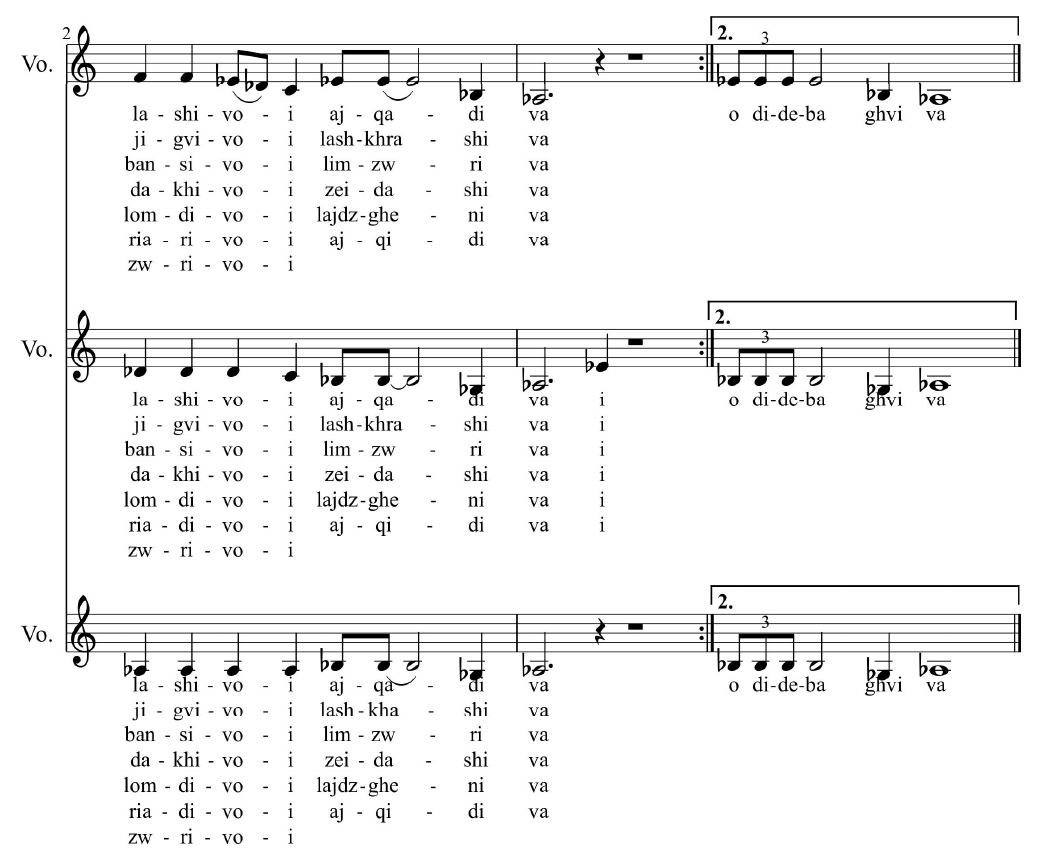
Figure 24. Barbal Dolash; Svan hymn to St. Barbara, Lakhushdi variant.